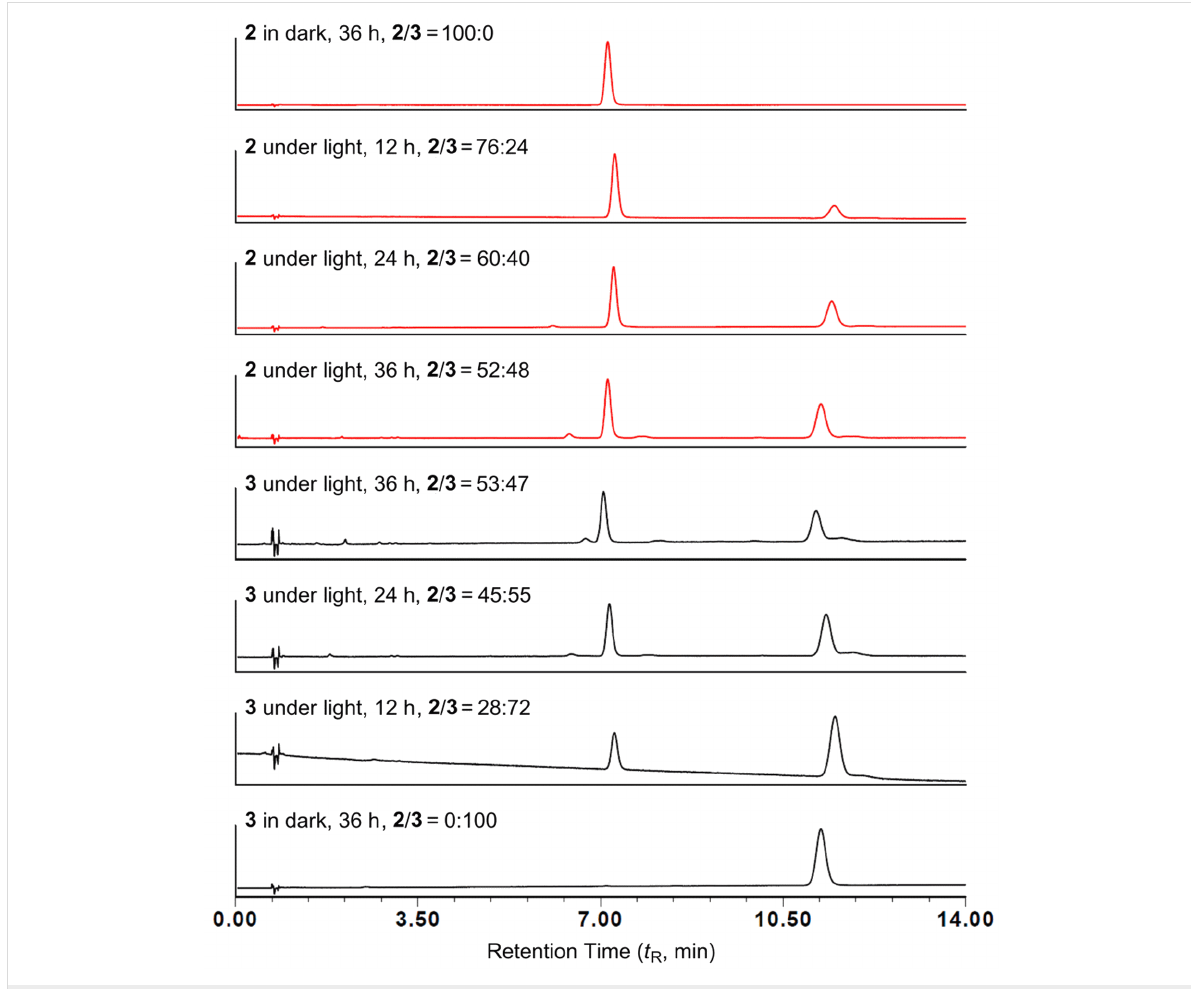
Figure 5: UPLC analysis of photoreaction products of 2 (around t R = 7.5 min) and 3 (around t R = 11.5 min).